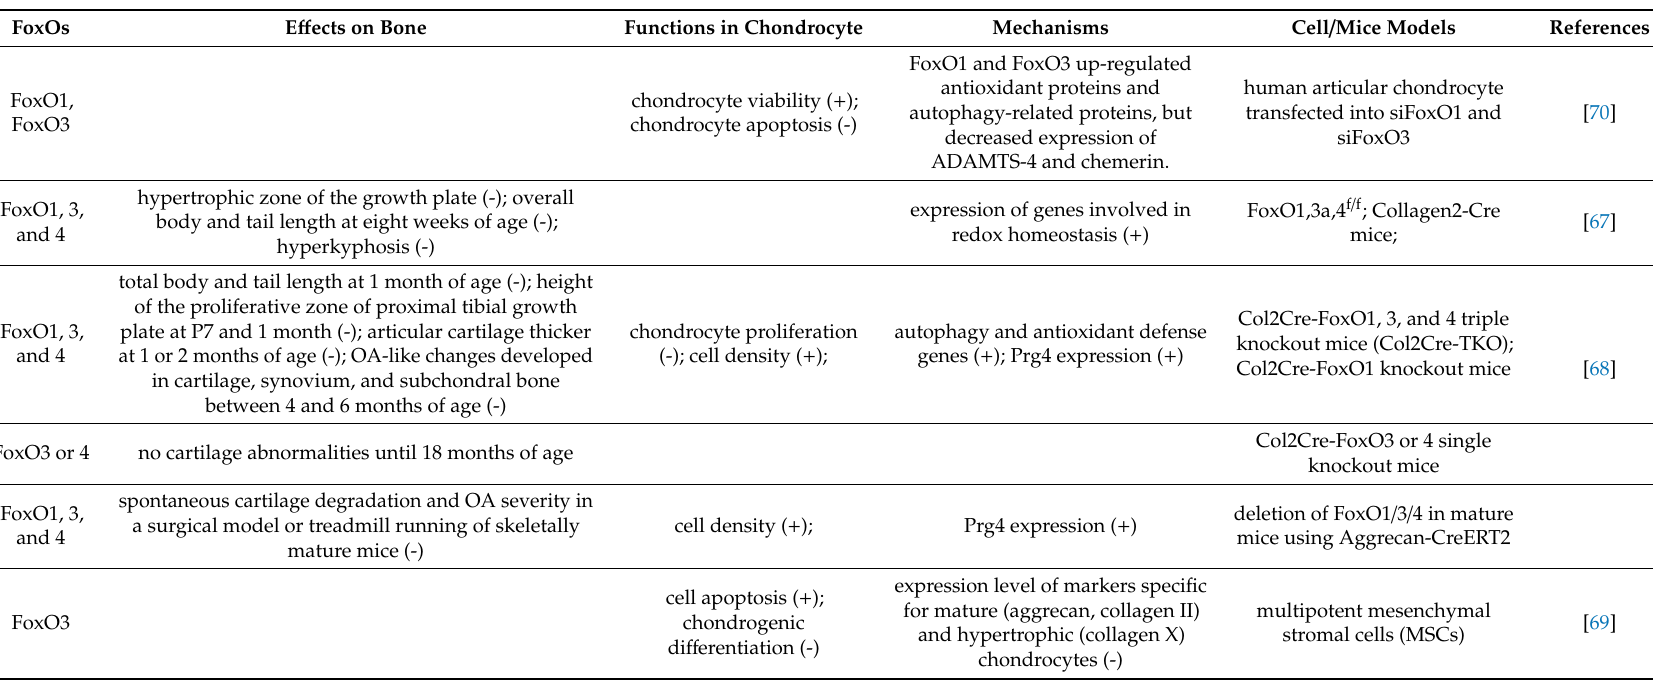
Table 5. Bone metabolism regulatory functions of FoxO transcription factors in